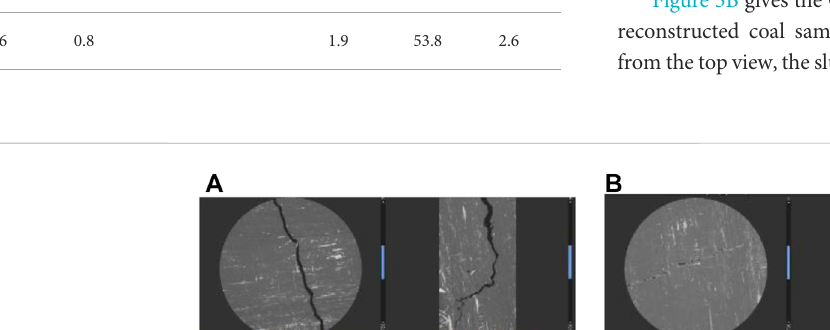
TABLE 1 Permeability measurement results.